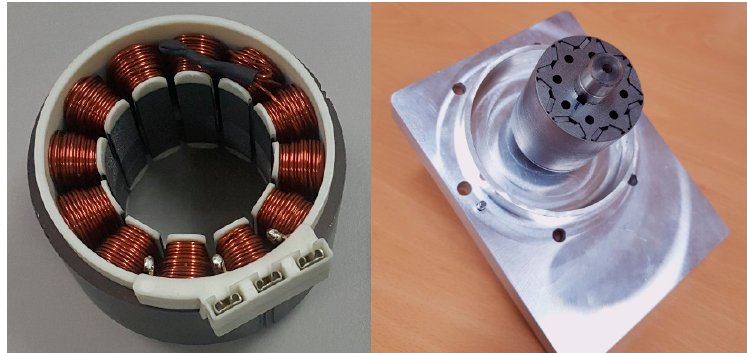
Figure 13. Stator and rotor manufactured for experiments.